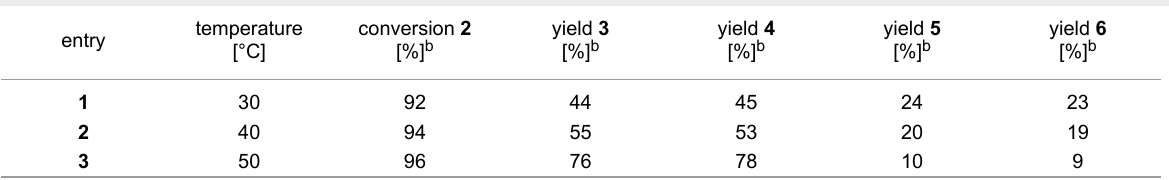
Table 5: Results of variation of the reaction temperature of cross-metathesis of 1 with 2 . a